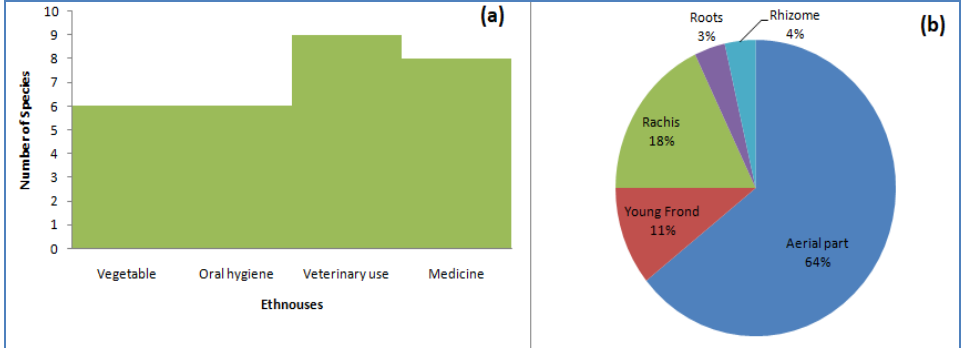
Figure 7. ( a ) Different uses of documented species; ( b ) Percentage of different parts of the documented species for the tradition uses. species for the tradition